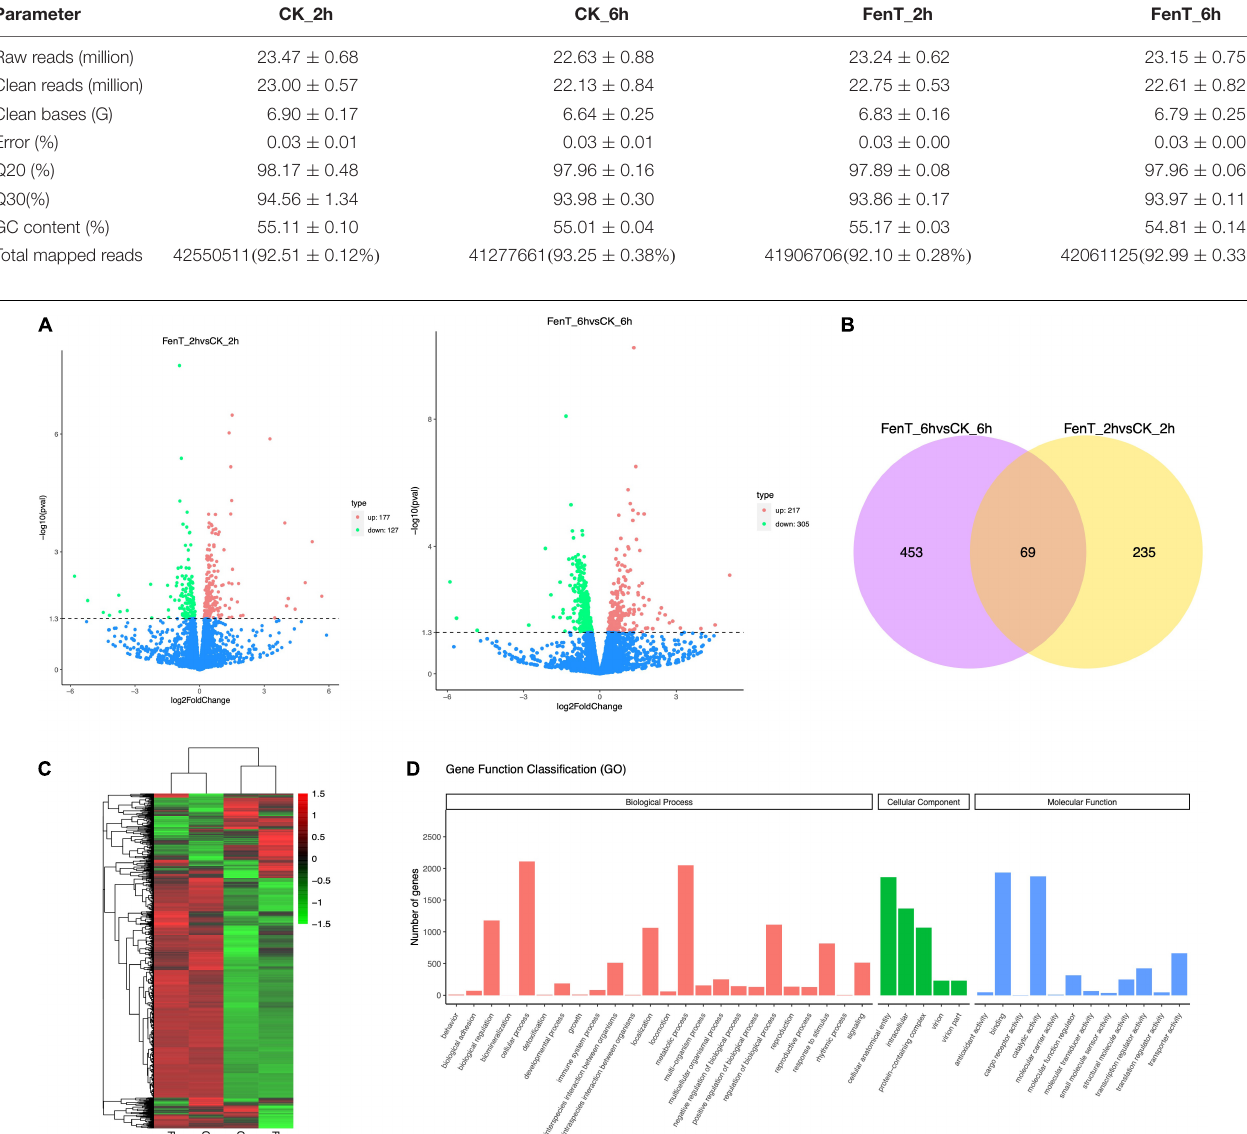
TABLE 2 | Profile of the transcriptome sequence data.